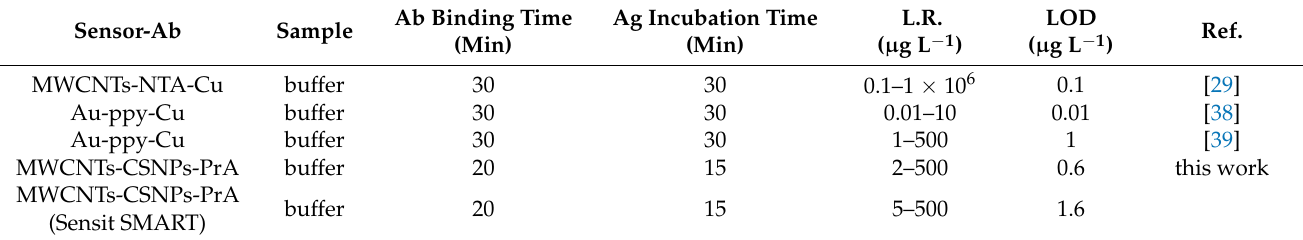
Table 2. Voltammetric immunosensors for D-dimer protein detection.